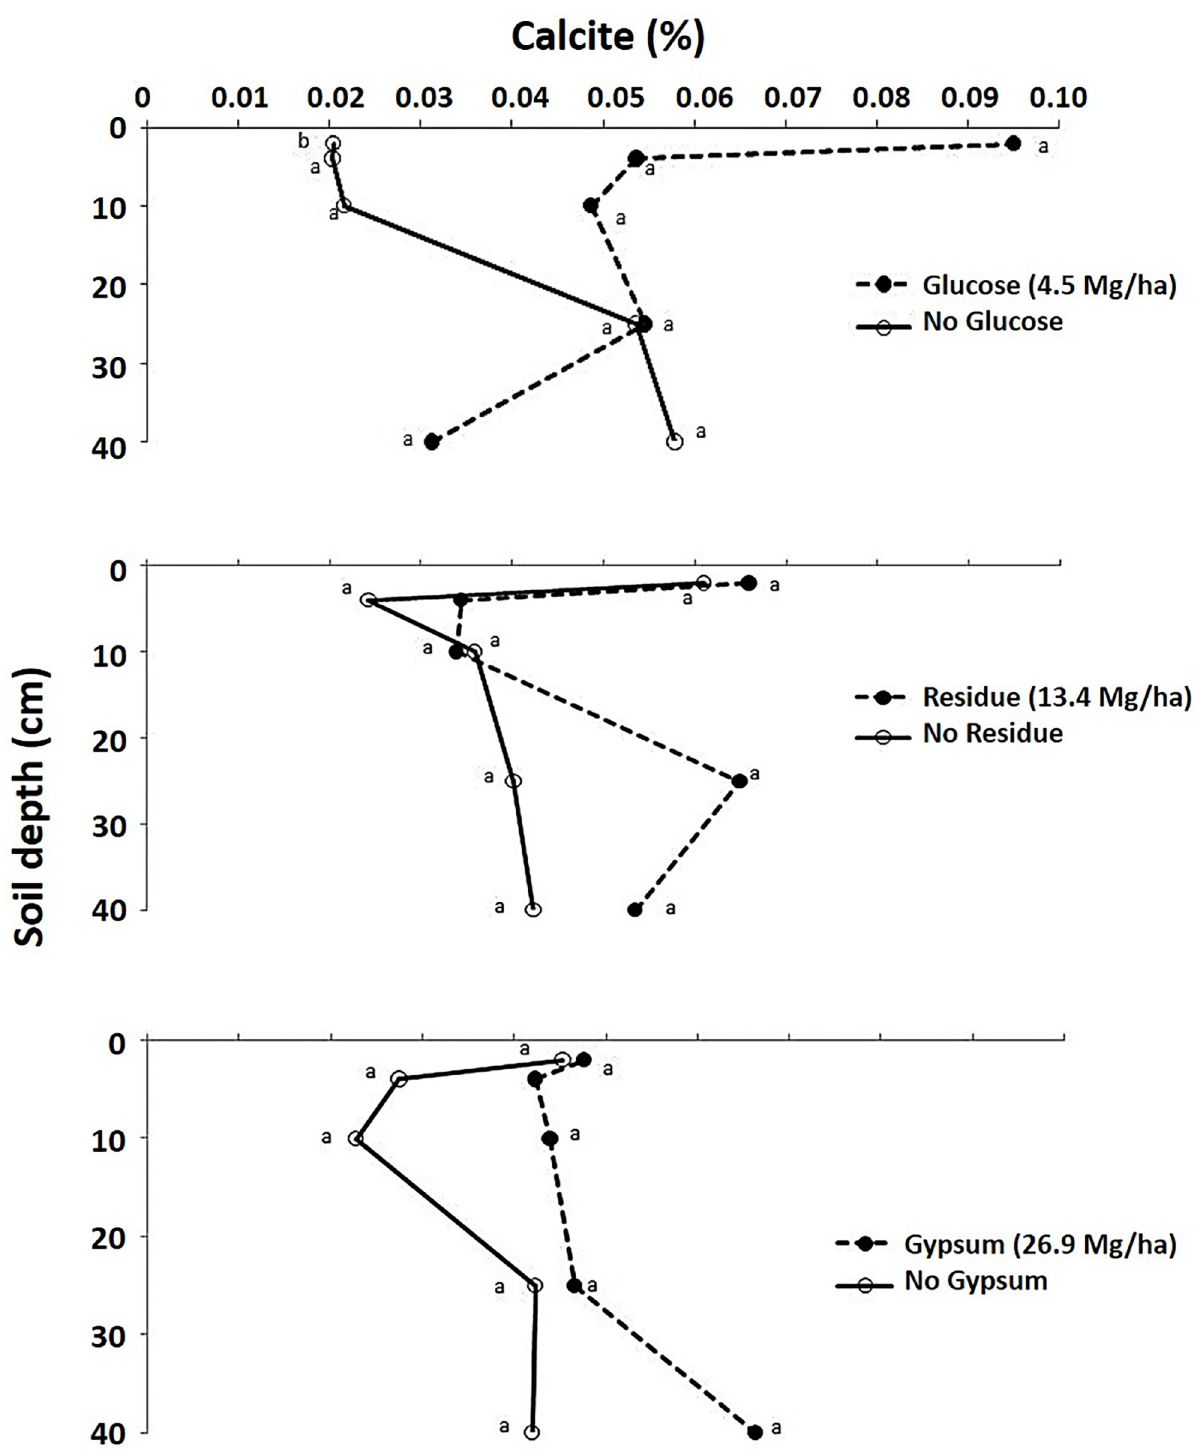
Fig 3. Effect of glucose, residue and gypsum addition on calcite (%) in different Hoytville soil layers. Means with the same letter within same layer are not statistically different (P < 0.10).